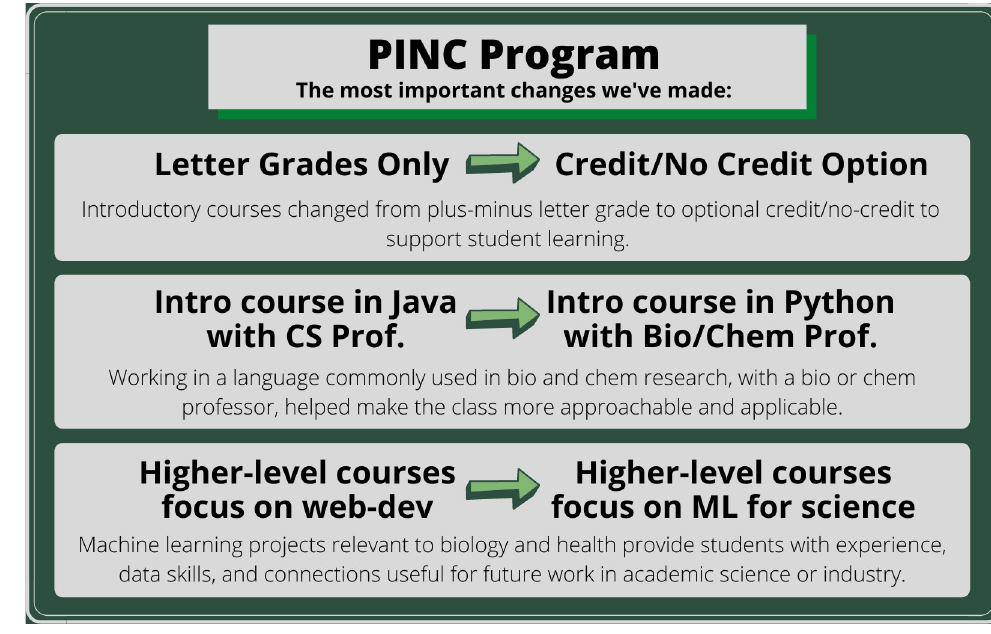
Fig 6. List of the main changes we made to the PINC minor between 2016 and 2021.